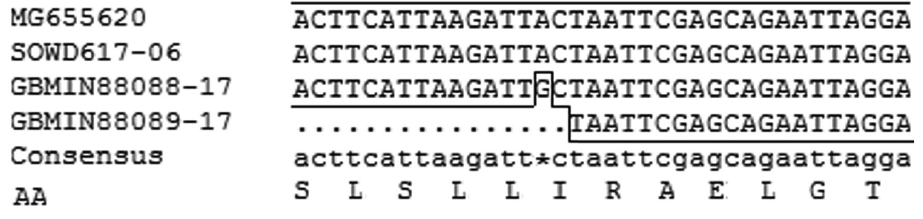
Figure 6. Barcoding analysis of T. japonica .